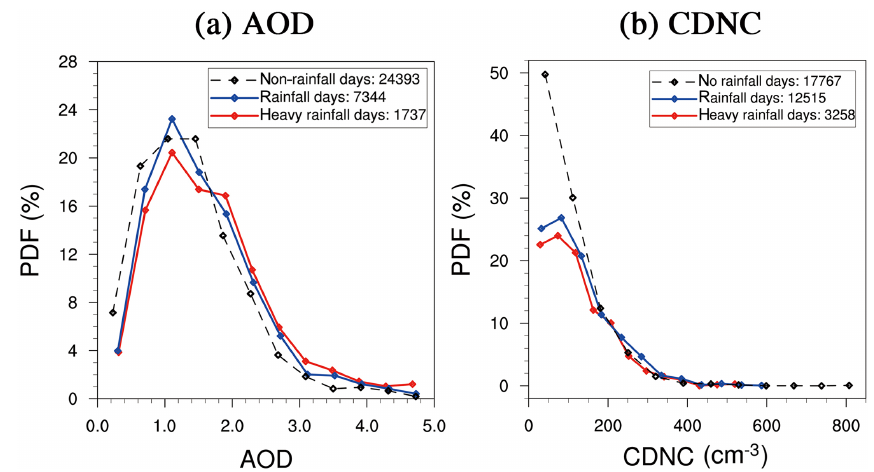
Figure 2. PDFs of (a) AOD and (b) CDNC (cm − 3 ) (data from MODIS) on non-rainfall days (black lines), rainfall days (blue lines) and heavy rainfall days (red lines) in southwesterly circulation during early summers from 2002 to 2012. Numbers in the legends denote the sample number.